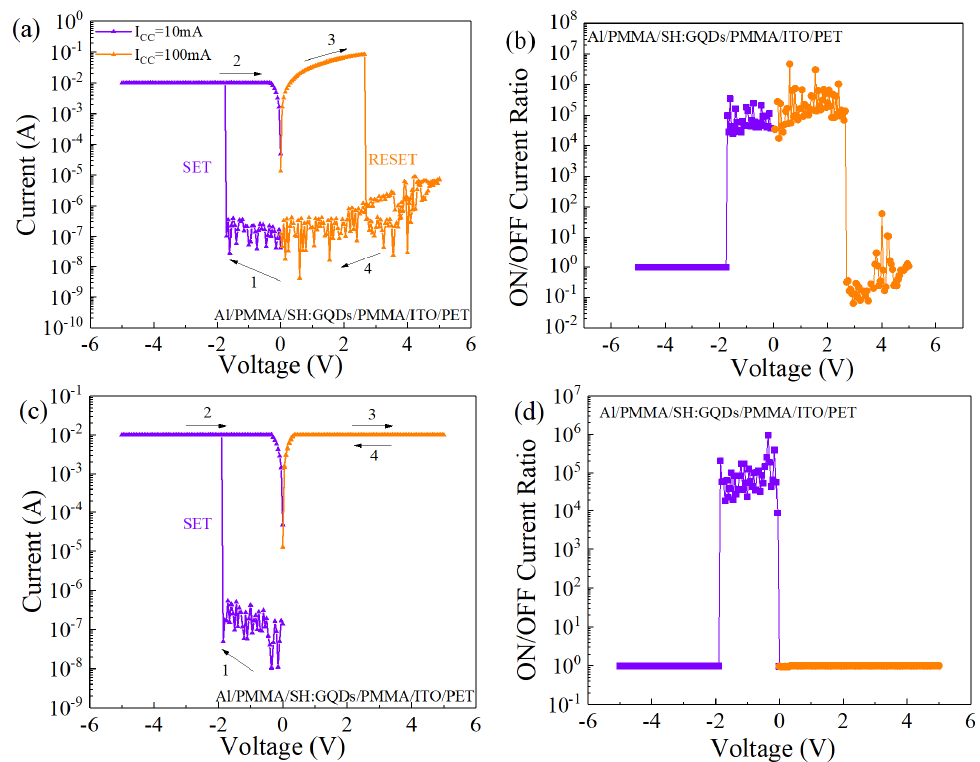
Figure 9. Electrical characteristics of the Al/PMMA/SH:GQDs/PMMA/ITO/PET device at different compliance currents: ( a , c ) I-V characteristic curve and ( b , d ) ON/OFF current ratio.